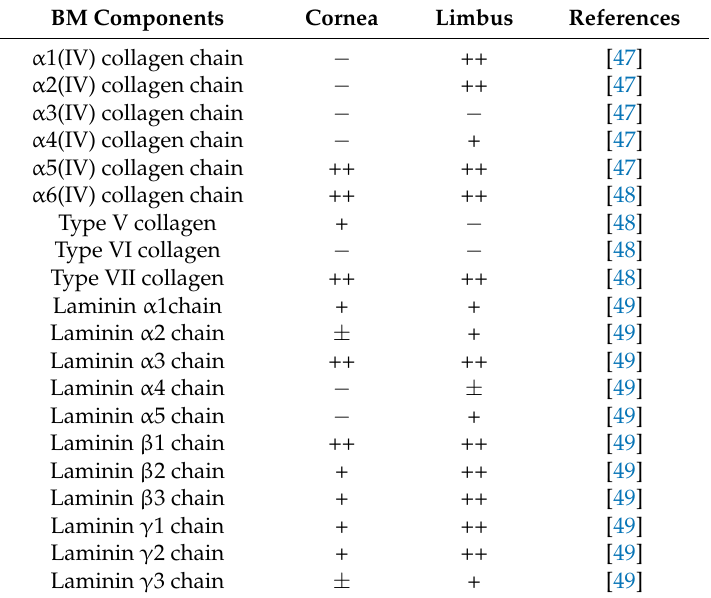
Table 1. Distribution of collagens and laminins on cornea and